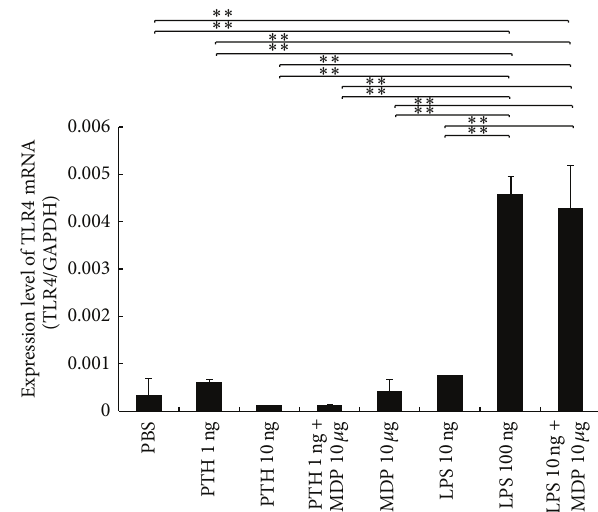
Figure 7: Enhancing lipopolysaccharide- (LPS-) induced Toll- like receptor (TLR4) expression using muramyl dipeptide (MDP) in vivo . Total RNA from mouse calvariae was isolated after 5 days of daily supracalvarial injections of PBS, PTH (1 𝜇 g/day), PTH (10 𝜇 g/day), PTH (1 𝜇 g/day) + MDP (100 𝜇 g/day), MDP (100 𝜇 g/day),LPS(10 𝜇 g/day),LPS(100 𝜇 g/day),orLPS(10 𝜇 g/day)+ MDP (100 𝜇 g/day). mRNA levels for TLR4 were normalized to those of GAPDH. Results are expressed as the mean ± SD ( 𝑛 = 4 ; ∗∗ 𝑃 < 0.01 ; ∗ 𝑃 < 0.05 ). Differences were determined using Scheffe’s 𝐹 test.